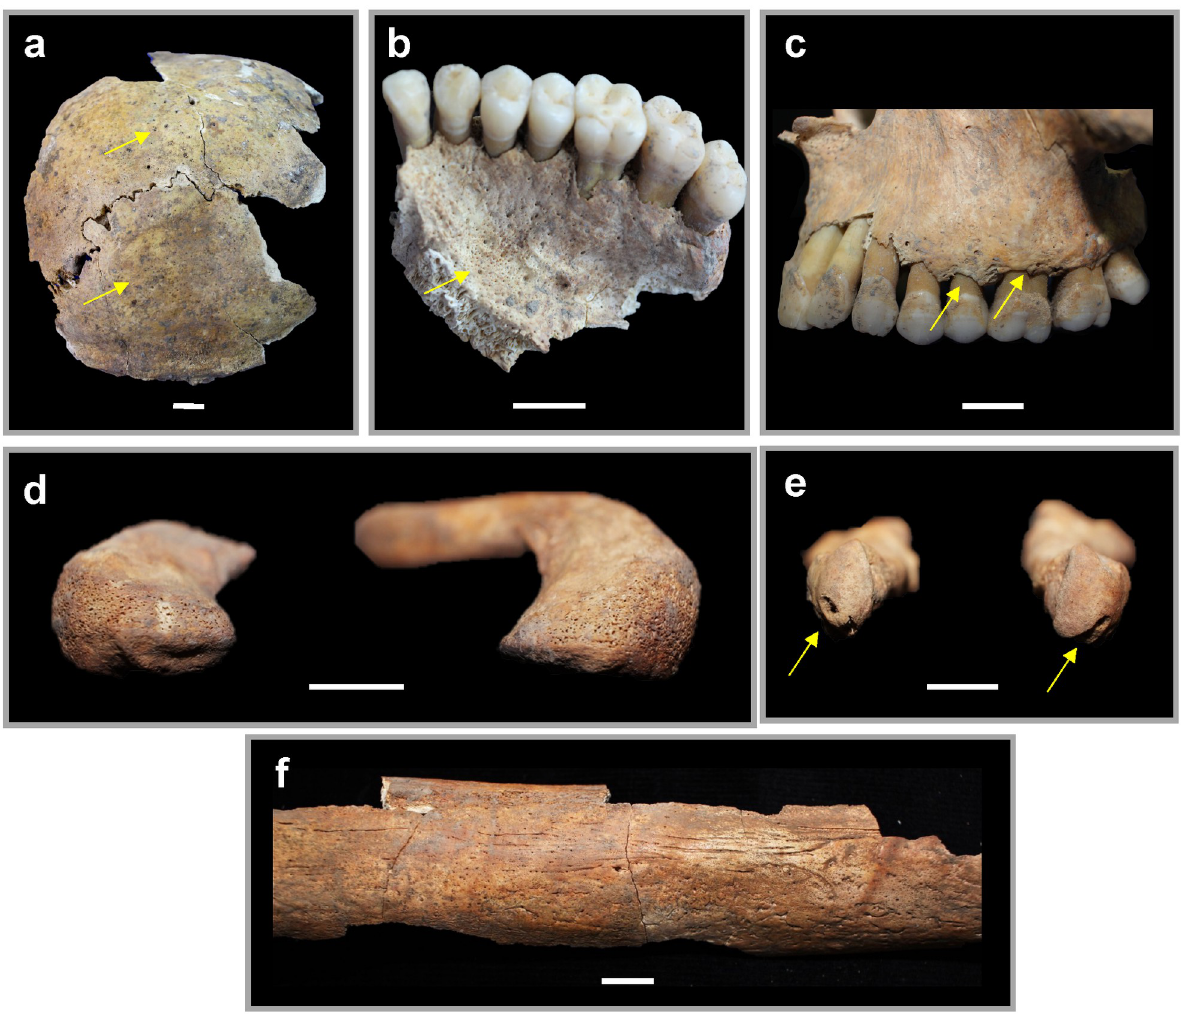
Fig 4. Selected lesions and anomalies of Individual 1. a: Posterior cranium with arrows pointing towards increased porosity. b: Left maxilla in inferior view with arrows highlighting the increased porosity of the hard palate. c: Left maxilla in lateral view with arrows showing alveolar recession. d: Osteolytic acromial ends of both clavicles in lateral view. e: Distal ends of both fifth metatarsals showing compressed heads with arrows pointing at the circular indentations, and f: Left humerus at midshaft with porosity and sclerotic periosteal impressions. All scale bars are 1 cm.